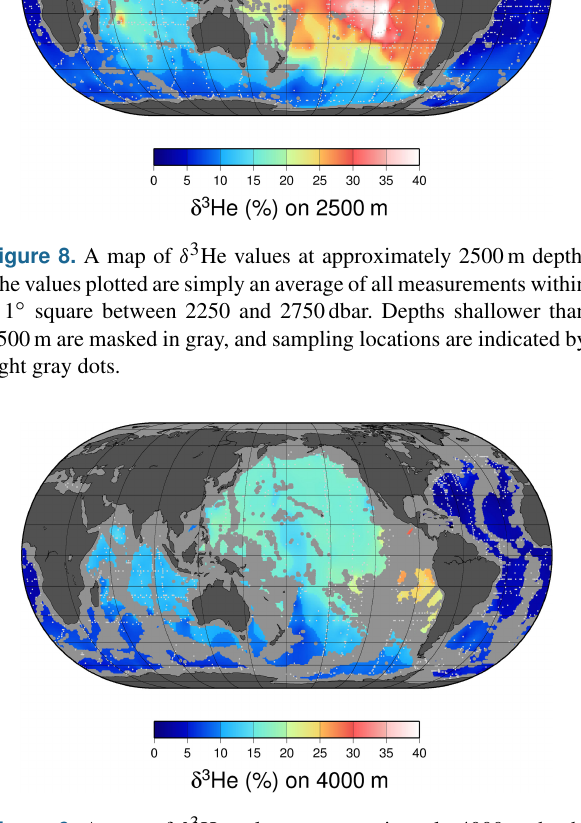
Figure 9. A map of δ 3 He values at approximately 4000m depth. The values plotted are simply an average of all measurements within a 1 ◦ square between 3750 and 4250dbar. Depths shallower than 4000m are masked in gray, and sampling locations are indicated by light gray dots.